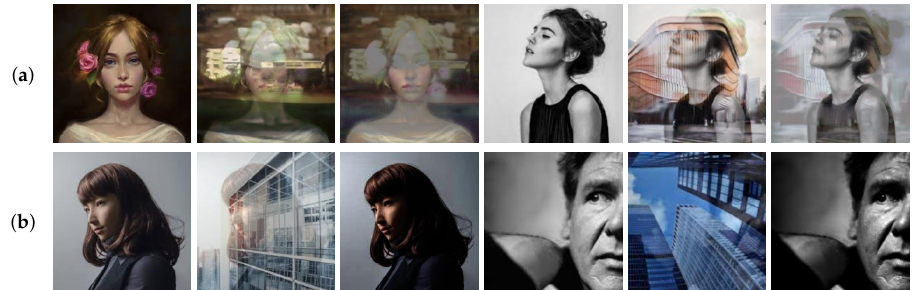
Figure 8. Example results by using the two synthesis methods [15,32]. ( a ) for [32] and ( b ) for